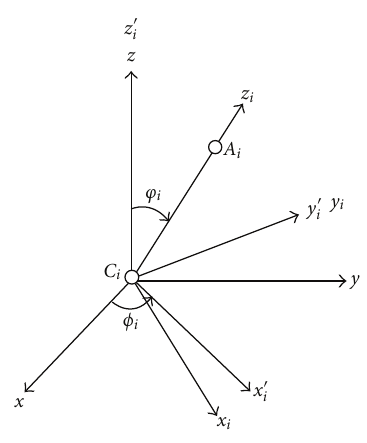
Figure 3: The local coordinate system of the i th strut.